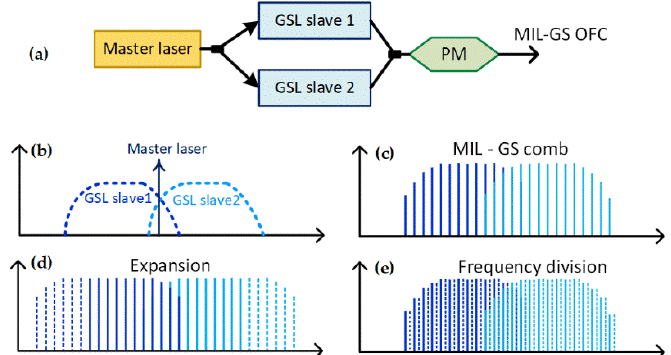
Figure 1. ( a ) Illustrative diagram of proposed MIL-GS OFC generation, expansion and comb densification scheme. ( b – e ) are the line graph of the operational principle.